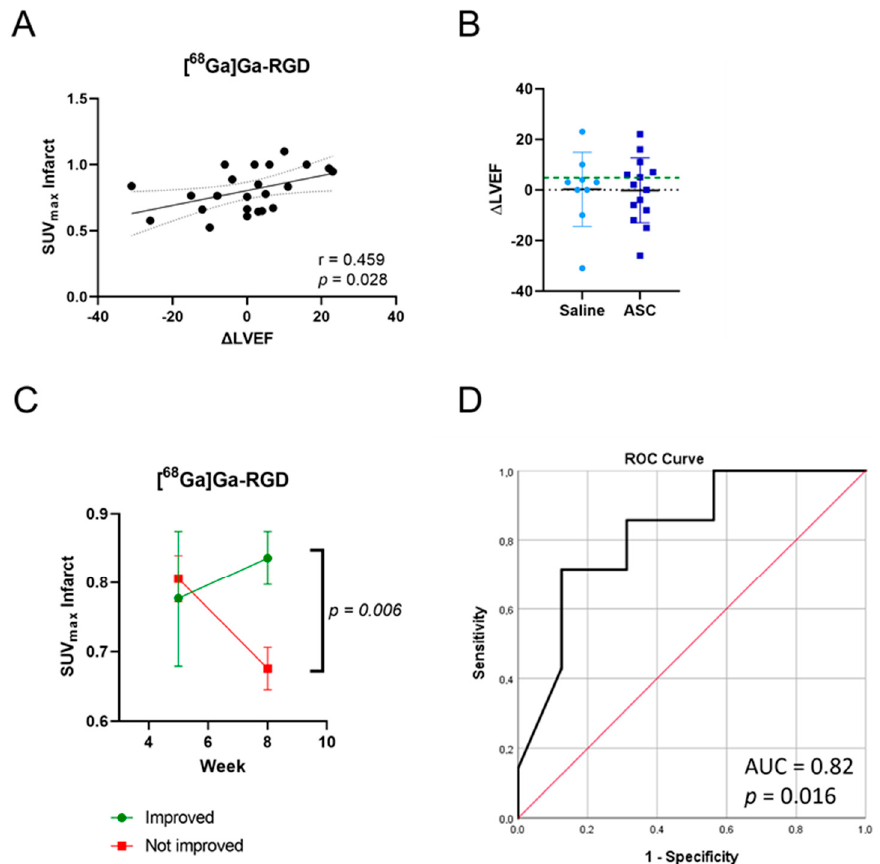
Figure 4. Correlation between [ 68 Ga]Ga-RGD uptake and change in LVEF ( A ). Animals were grouped based on their changes in LVEF ( B ), with 5 percentage points being the cut-off between groups (the green dotted line). Differences in uptake of [ 68 Ga]Ga-RGD between animals that improved LVEF and those that did not ( C ). ROC analysis for predicting LVEF based on [ 68 Ga]Ga-RGD uptake with SUV max at week 8 (two weeks after treatment) ( D ), n = 23. ROC: Receiver-operating-characteristic.